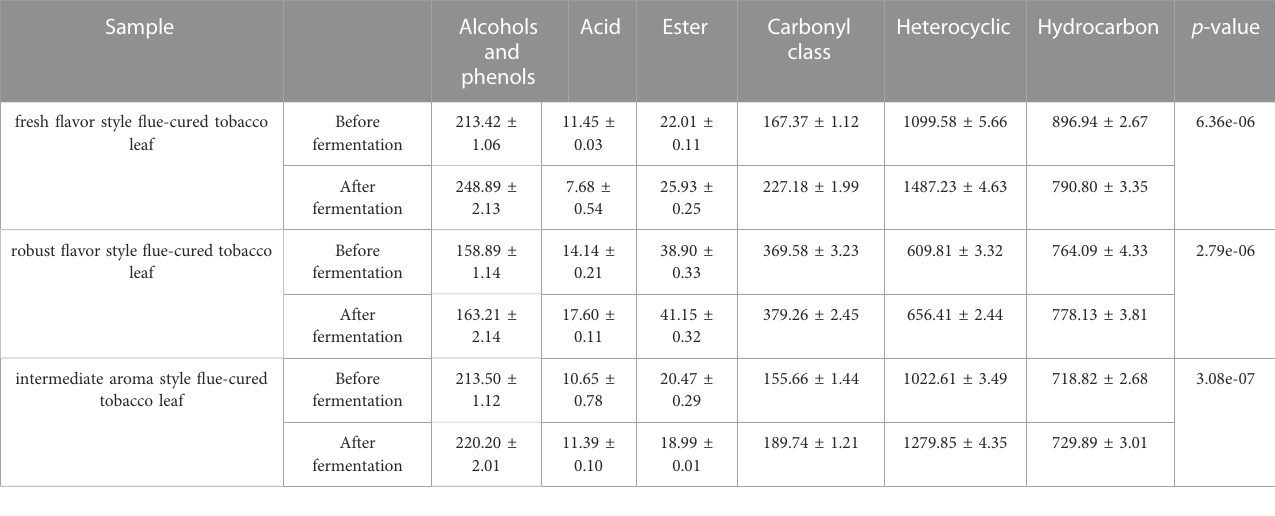
TABLE 2 Changes of volatile components in tobacco leaves treated by strain 44# (ug/g).